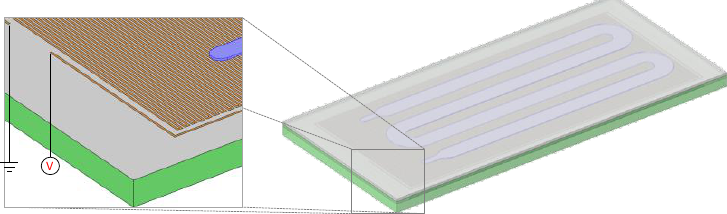
Figure 2. Schematic of the microPCR design used for the computational study. The PCB (green) layer incorporated a meander-shaped copper line (brown) operating as a microheater. A PMMA layer (gray) lay on top of the PCB layer and included a microchannel which was sealed by a polyolefin layer.